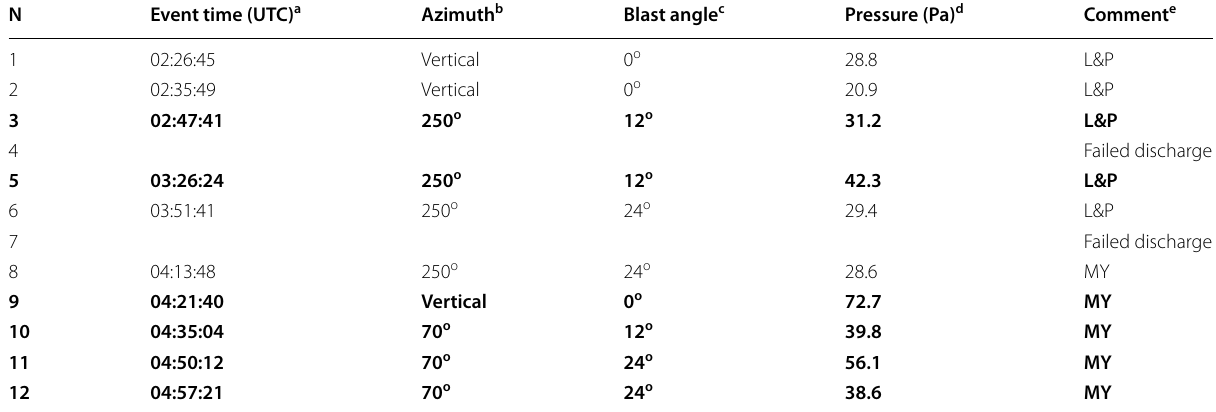
Table 1 Experiment results